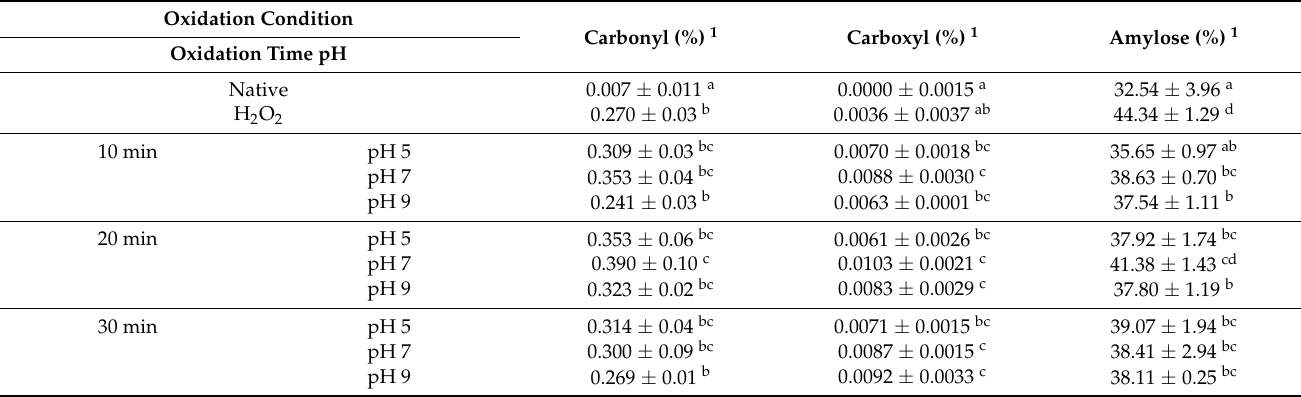
Table 1. Carbonyl, carboxyl, and amylose content of ozone-oxidized tapioca compared to native and H 2 O 2 -oxidized tapioca. Oxidation Condition